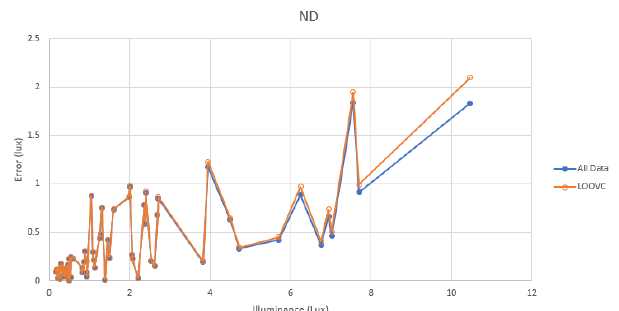
Figure 15. Absolute residual plot from all data and LOOVC of regression model of